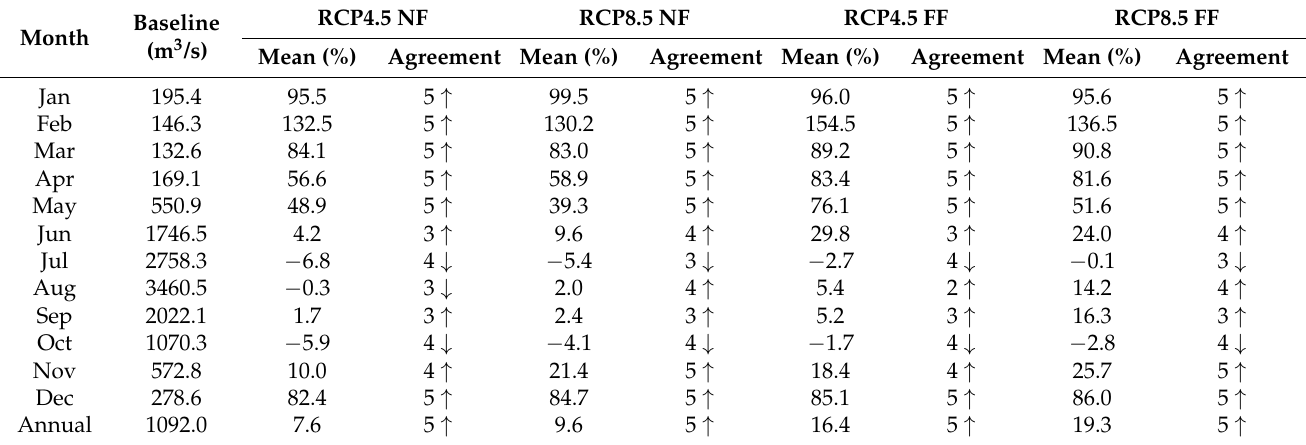
Figure 10. Baseline and projected mean annual flows at the outlet of Sittaung under RCP4.5 and RCP8.5 scenarios. Table 8. Mean monthly baseline and future flows (m 3 /s) in the Sittaung river basin. The arrows in agreement indicate the direction of change with up arrow indicating increase and down arrow indicating decrease from baseline